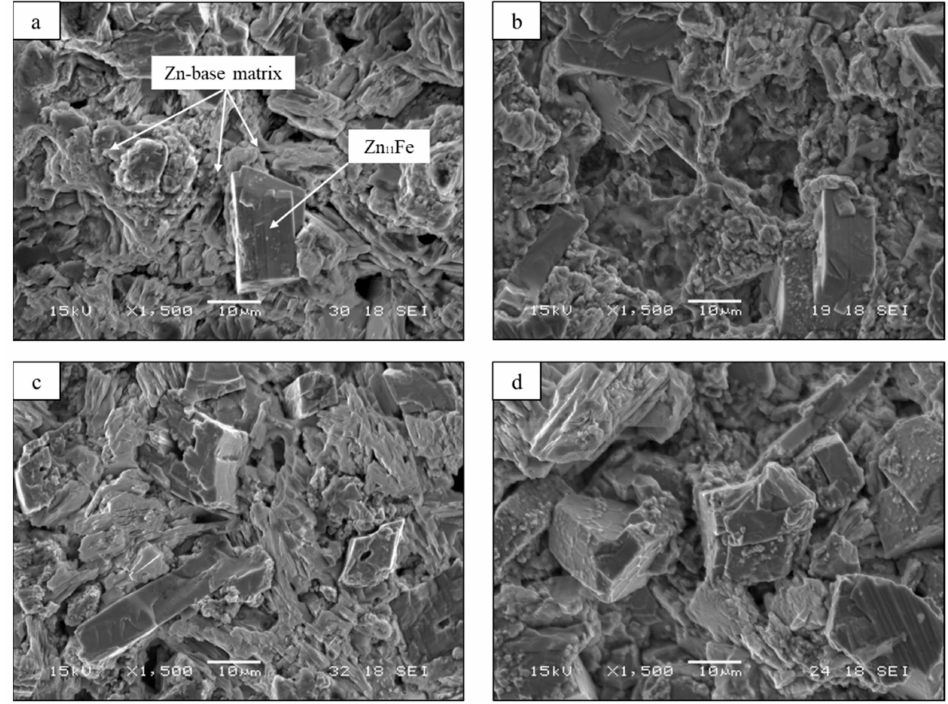
Figure 8. Close-up views of the corrosion products at the external surface of tested alloys after immersion test in PBS solution for 14 days. ( a – d ) Same specimen in different location. Measurements of the open circuit potential (OCP) of the tested alloys, immersed in PBS solution for up to 90 h, is presented in Figure 9. The OCP of all tested alloys was within the range of − 1.04 V and − 1.09 V, with an arbitrary effect of Mn addition. This, in practice, means that the effect of Mn on OCP was insignificant, as indicated by the immersion tests.